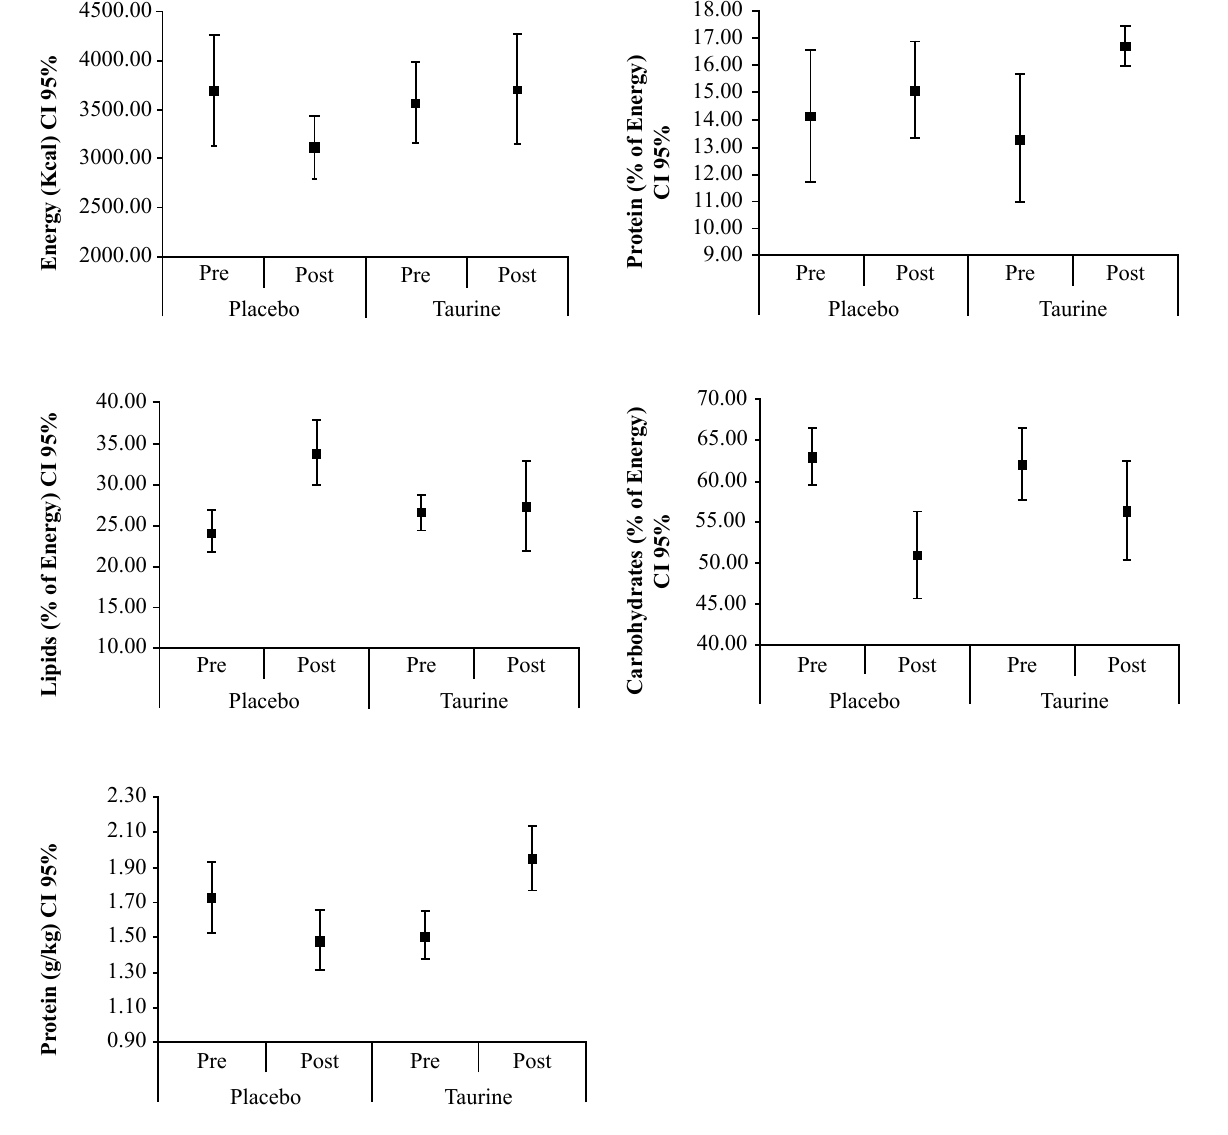
Figure 1. Evaluation of food intake before (Pre) and after (Post) 8 weeks of placebo or taurine supplementation (n =